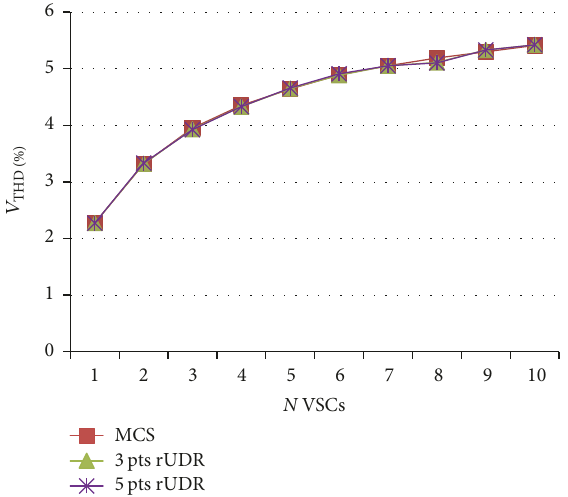
Figure 8: Predicted VgaTHD using MCS, rUDR 3 pts, and rUDR 5 pts under Power Variation.